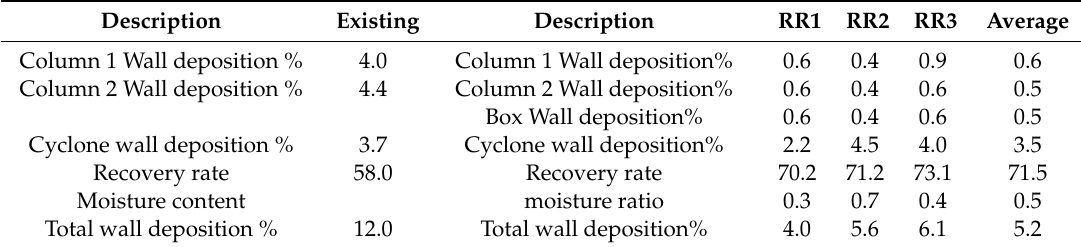
Table 13. Overall deposition percentages for an 8.8 wt% solids concentration feed at an inlet air temperature of 230 °C (RR1 = run 1, RR2 = run 2, RR3 = run 3). The standards error for the deposition percentages is 0.6%.